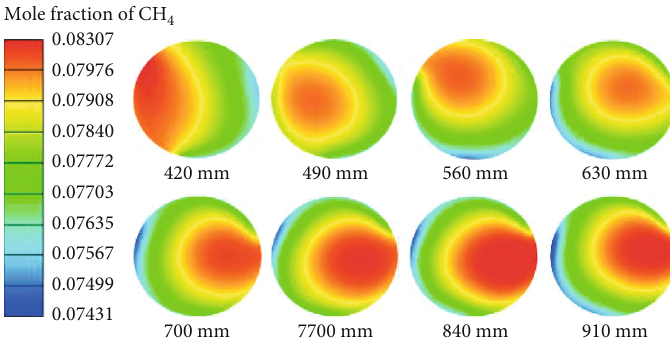
Figure 11: In fl uence of length of spiral blade on the uniformity of gas in tubule